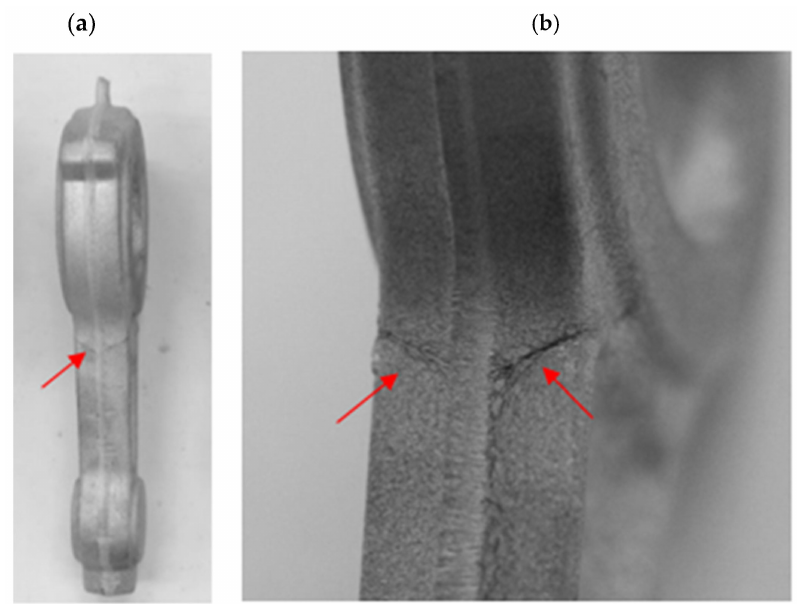
Figure 24. Forgings of connecting rods made of AB-71100 aluminum alloy after trimming the flash and the etching process, obtained from a preform in accordance with variant 1 with visible cracks ( a ); detailed view of the location of cracks in the forging ( b ).